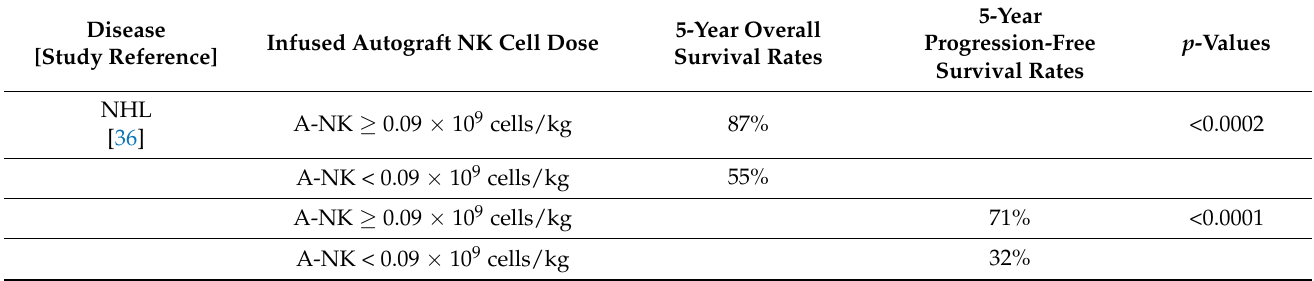
Table 1 summaries the clinical outcomes based on NK cells post-APBHCST. Table 1. Summary of clinical outcomes post-autologous peripheral blood hematopoietic stem cell transplantation based on the quantitative and qualitative immune mechanisms of action of natural killer